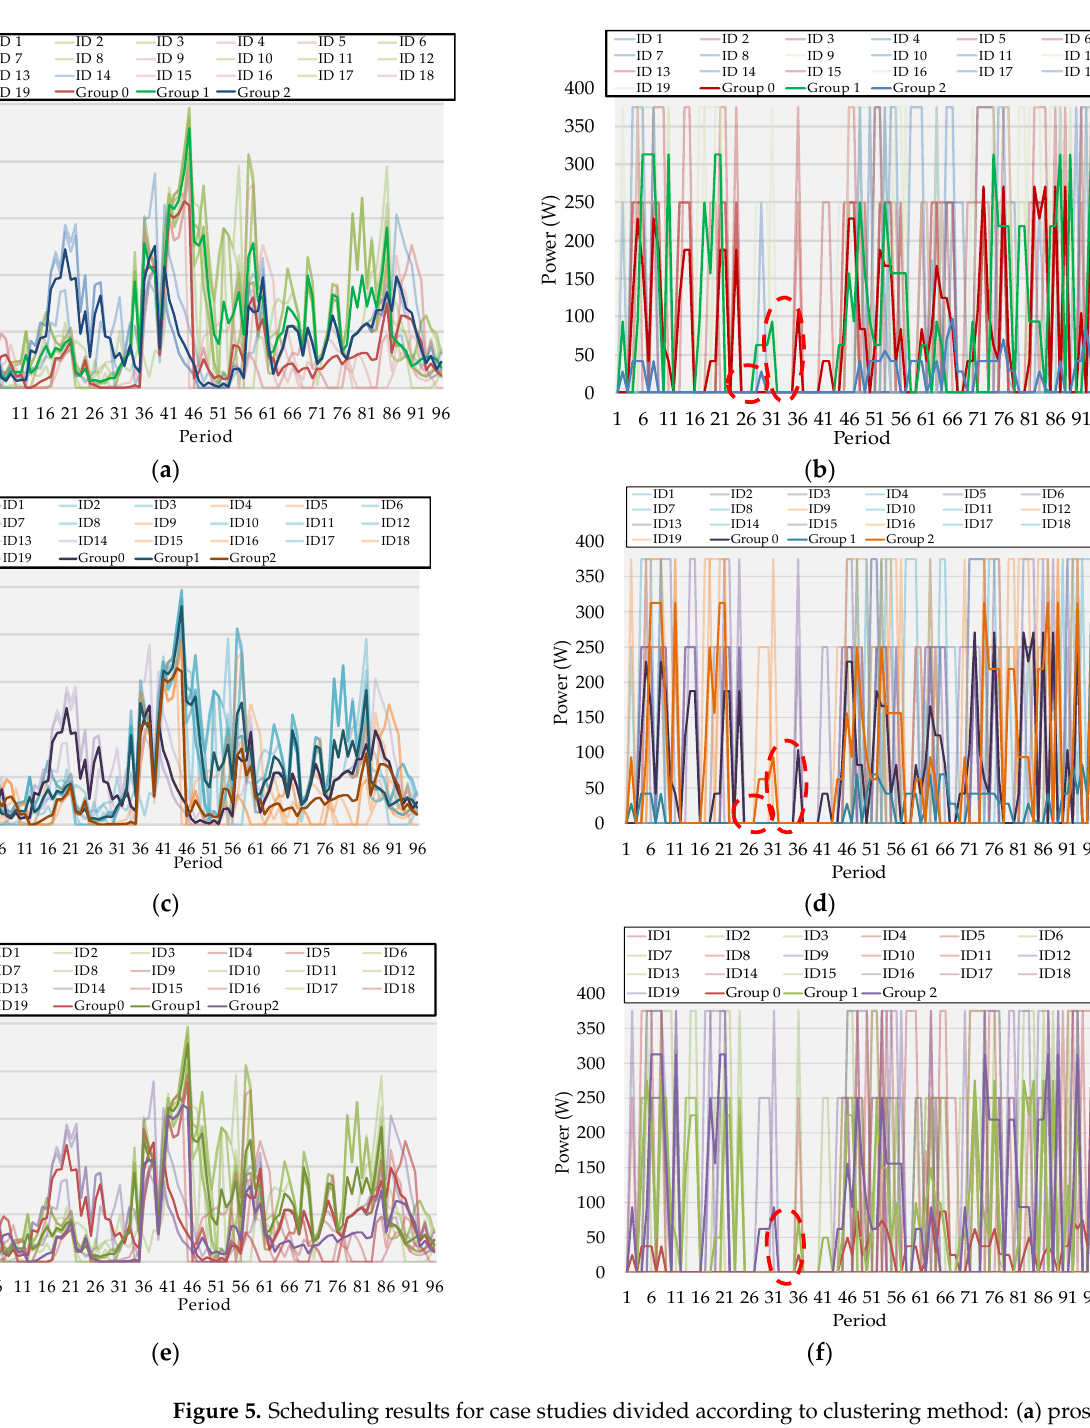
Figure 5. Scheduling results for case studies divided according to clustering method: ( a ) prosumers’ load flexibility per period for case study 1, ( b ) prosumers’ BES discharging per period for case study 1, ( c ) prosumers’ load flexibility per period for case study 2, ( d ) prosumers’ BES discharging per period for case study 2, ( e ) prosumers’ load flexibility per period for case study 3, ( f ) prosumers’ BES discharging per period for case study